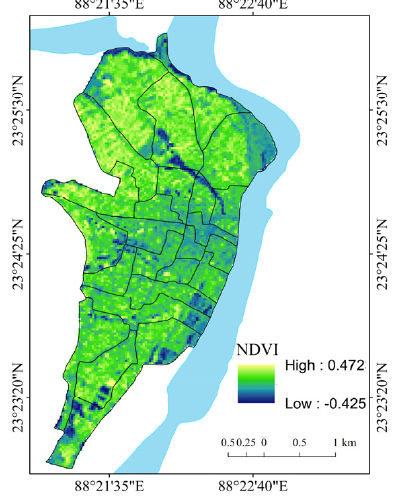
Figure 20. NDVI (2000).